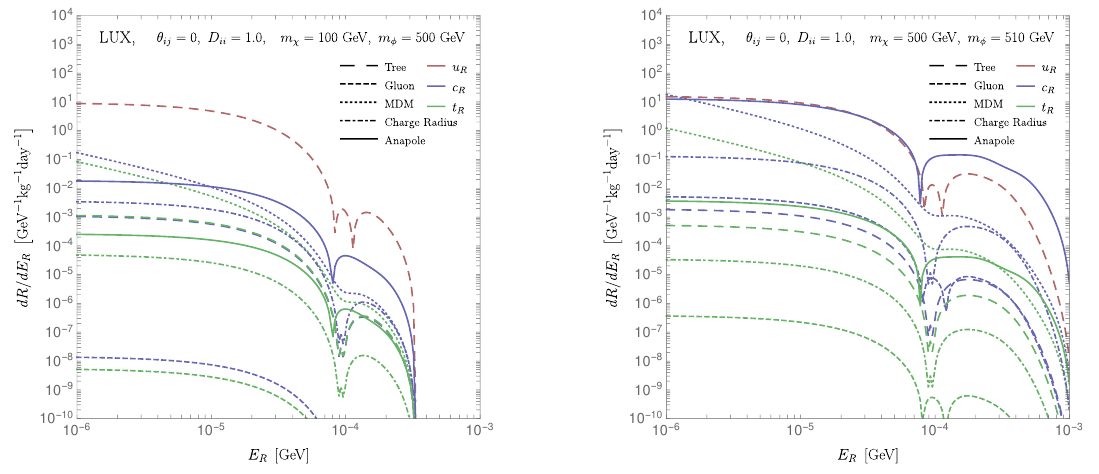
Figure 7 . The di(cid:11)erential scattering rate in recoil energy for DM-nuclear scattering at LUX. Each of the quark contribution are plotted separately, the rates are also separated according to the way in which they scatter. The right plot represents a model with almost complete degeneracy between the DM and mediator mass, where the loop level interactions become